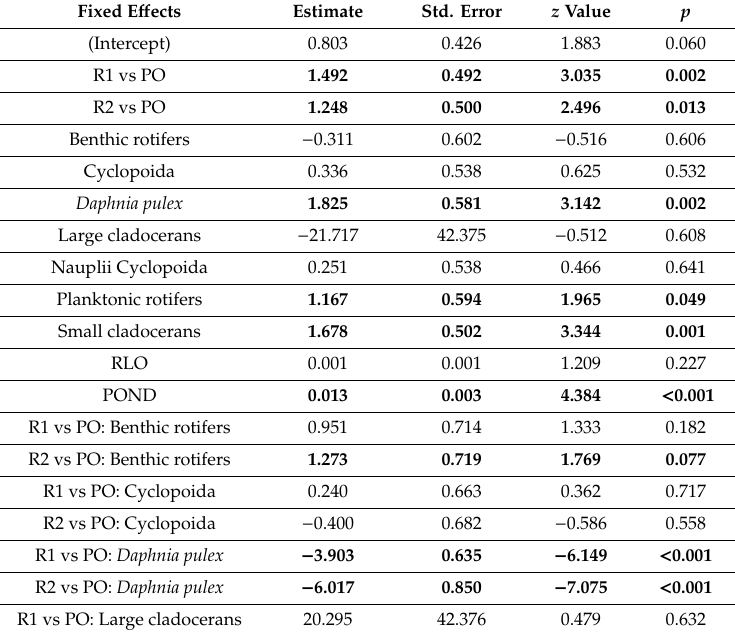
Table 3. Estimates of fitted model with species abundance as dependent variable. Significant results are marked with